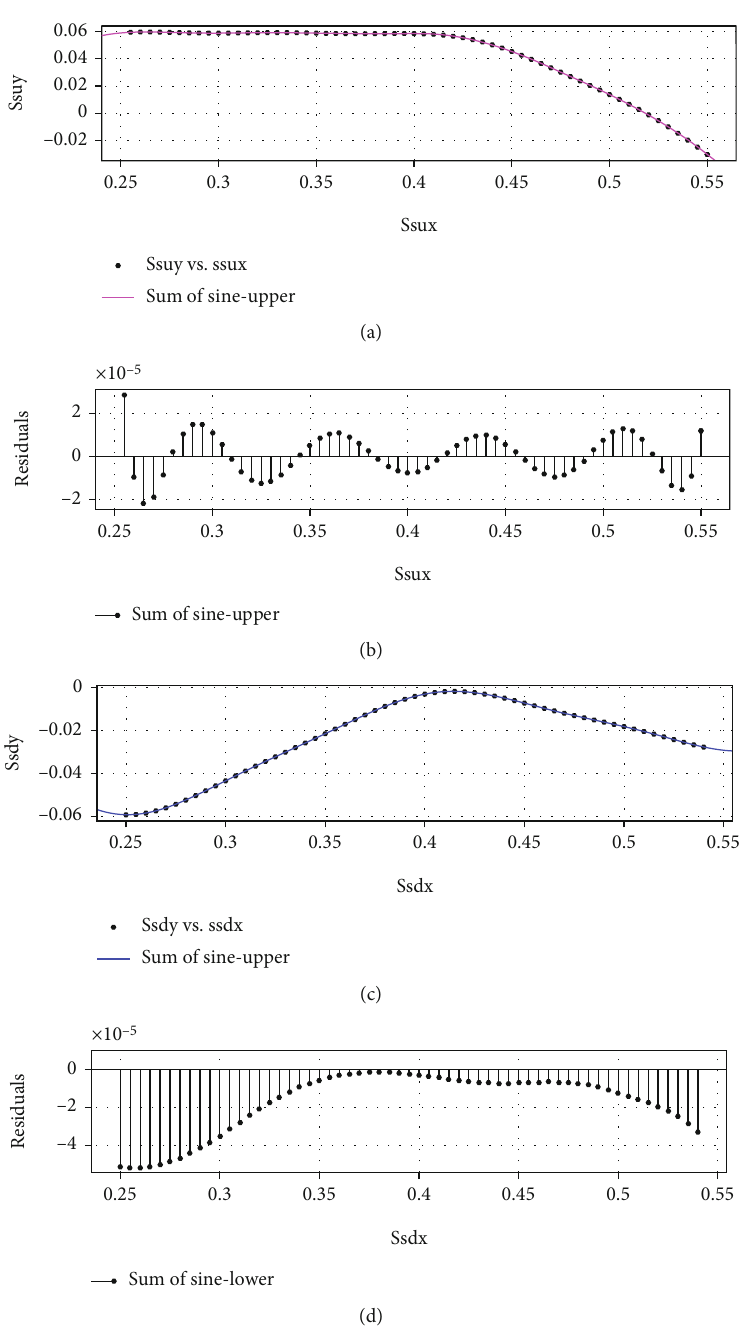
Figure 3: Fitting shapes and errors of SoS method for (a) fi tting shape of upper surface, (b) fi tting error of upper surface, (c) fi tting shape of lower surface, and (d) fi tting error of lower